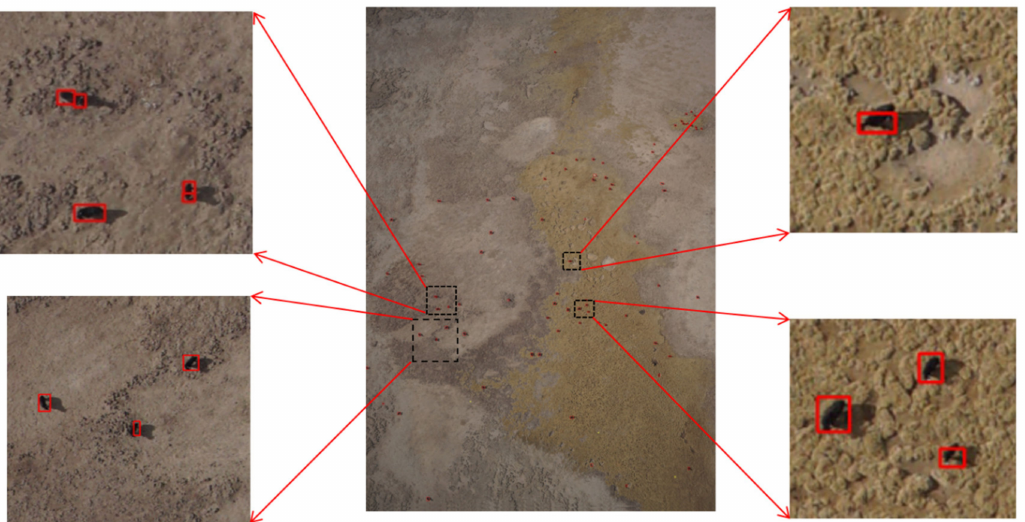
Figure 15. Result diagram of detection performed using bisection segmentation (the red boxes in the figure are the detection result boxes detected by the improved Faster-RCNN model using the bisection segmentation